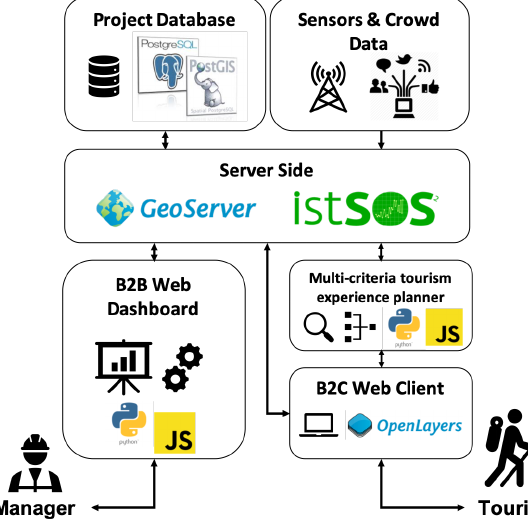
Figure 4. Preliminary architecture of the INSUBRIPARKS IT